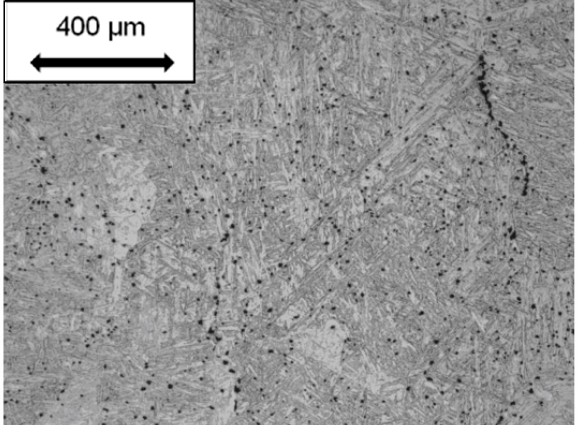
Figure 2. Micrograph showing detail of creep cavities formed in the base metal of a Grade 92 CSEF steel. These creep voids nucleate at a size below 1 µ m and grow during component life. The sample shown here is close to final fracture, yet no macro cracks had formed.